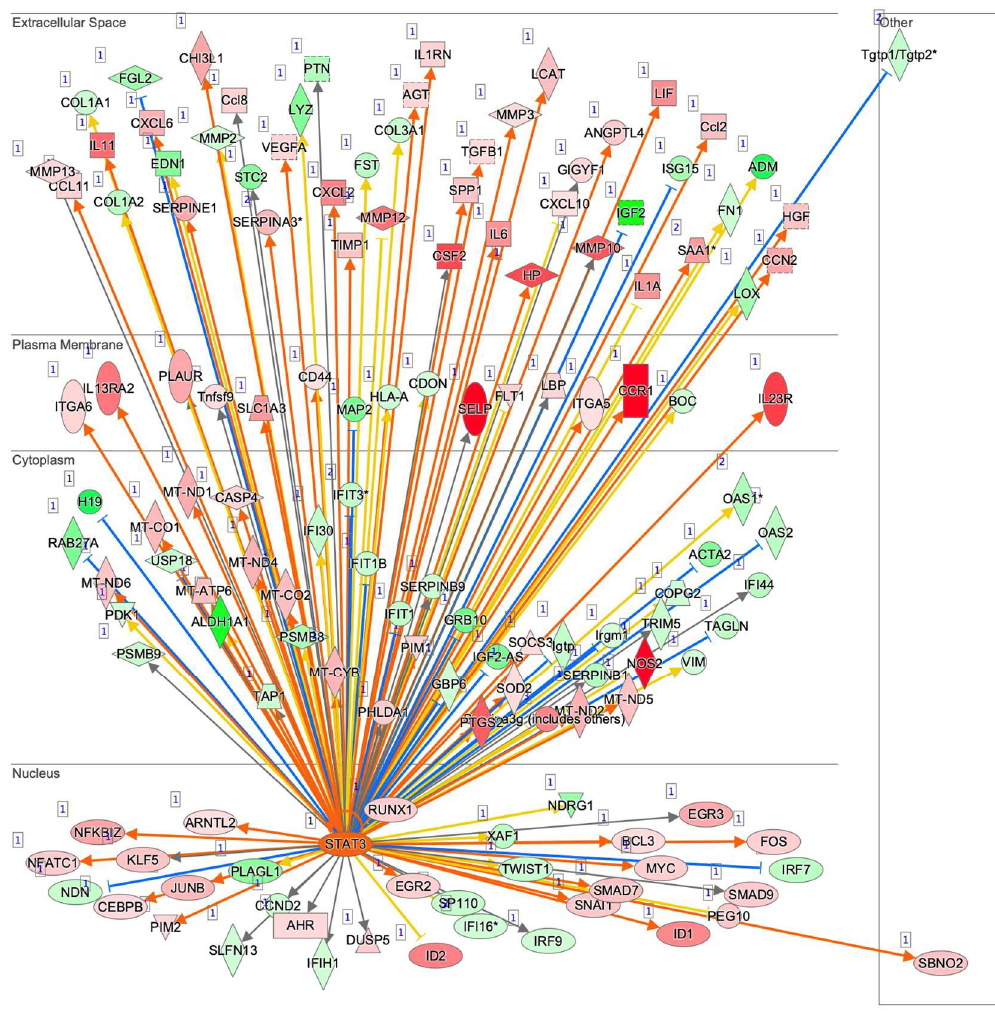
Figure 7. Upstream regulator analysis by IPA. Upstream analysis in IPA identified TGF β 1, STAT3, IL6, AGT, FOS, and MYC as master regulators. The graphs and the networks of each regulator were obtained through the use of IPA (QIAGEN Inc., https://www.qiagenbioinformatics.com/products/ingenuity-pathway-analysis, accessed on 3 November 2021). Among these, the STAT3 network is demonstrated, and others are shown in Figure S2. Prediction legend is shown in Figure S1. Table 1. Lists of the top 14 causal networks of diseases and functions with IPA network score of more than